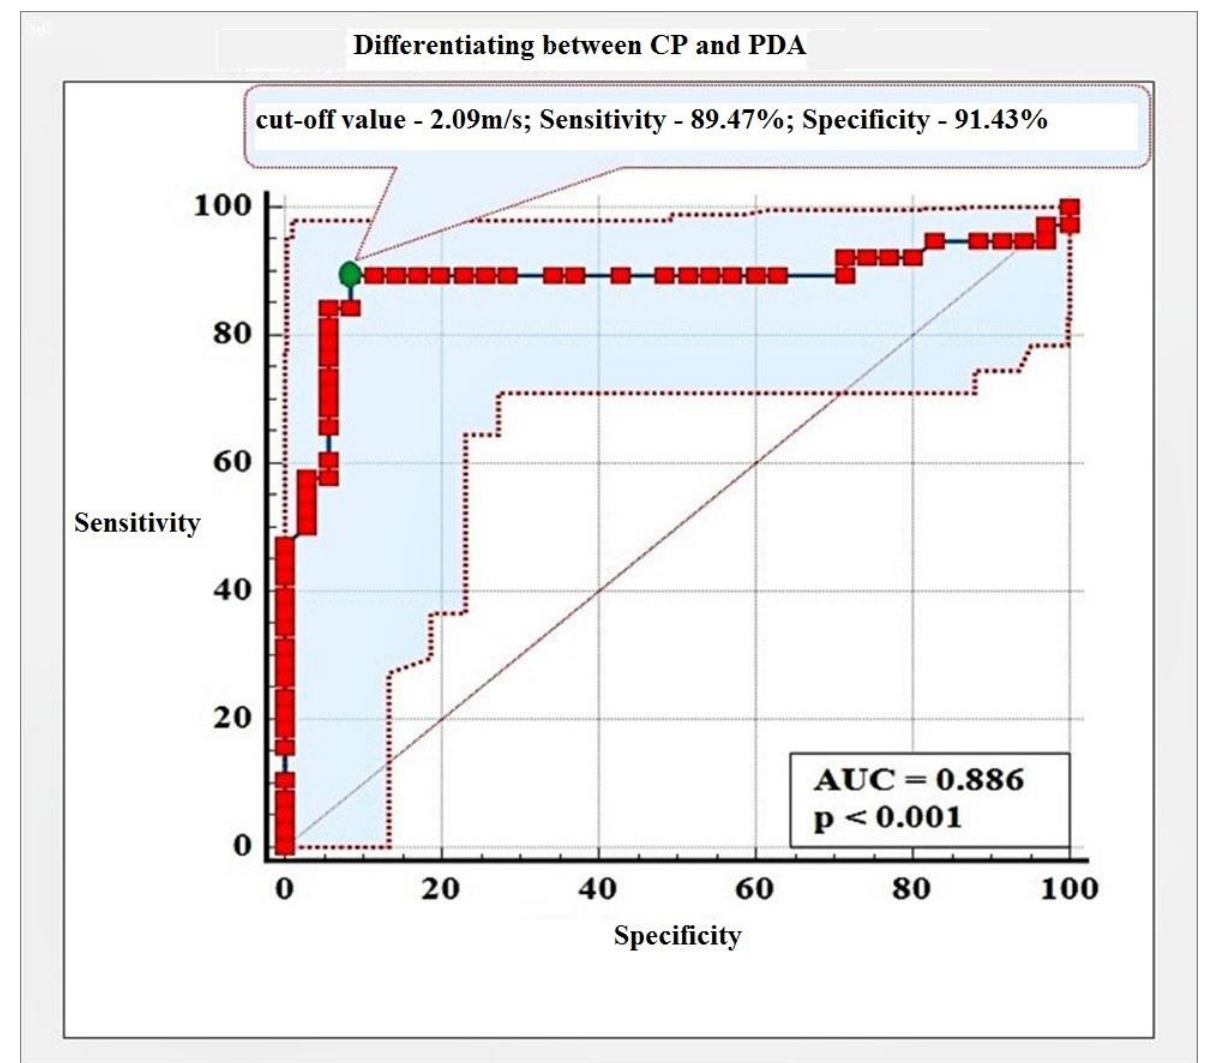
Figure 4. Performance of pSWE for differentiating between CP and PDA.